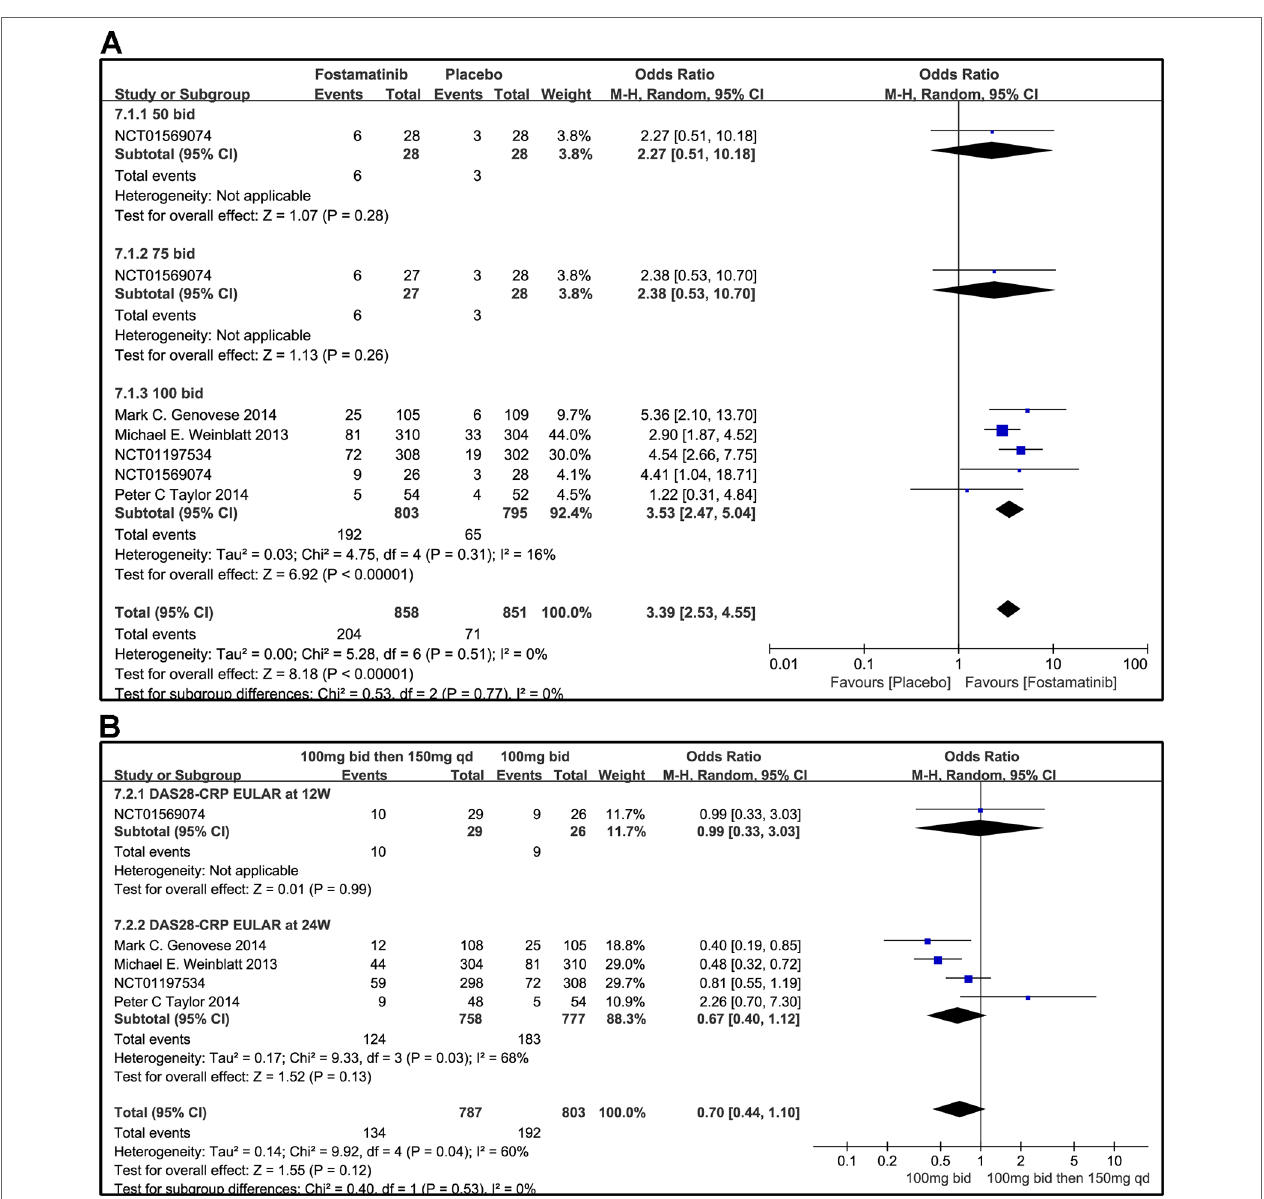
FIGURE 9 | Forest plots for the effect of multiple doses on DAS28-CRP EULAR (only considering good response) at different time points. (A) Subgroups administered multiple doses (50, 75, and 100 mg bid) of fostamatinib compared to placebo at 24 weeks from baseline; (B) 100 mg bid for 4 weeks followed by 150 mg bid vs. 100 mg bid at 12 and 24